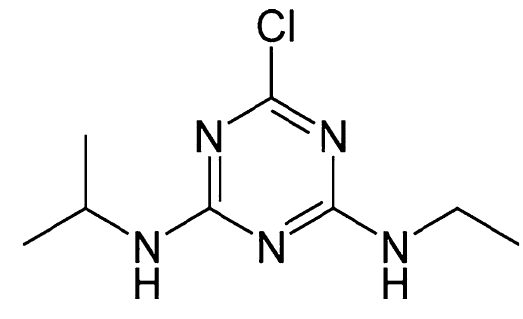
Fig. 1 Structure of atrazine